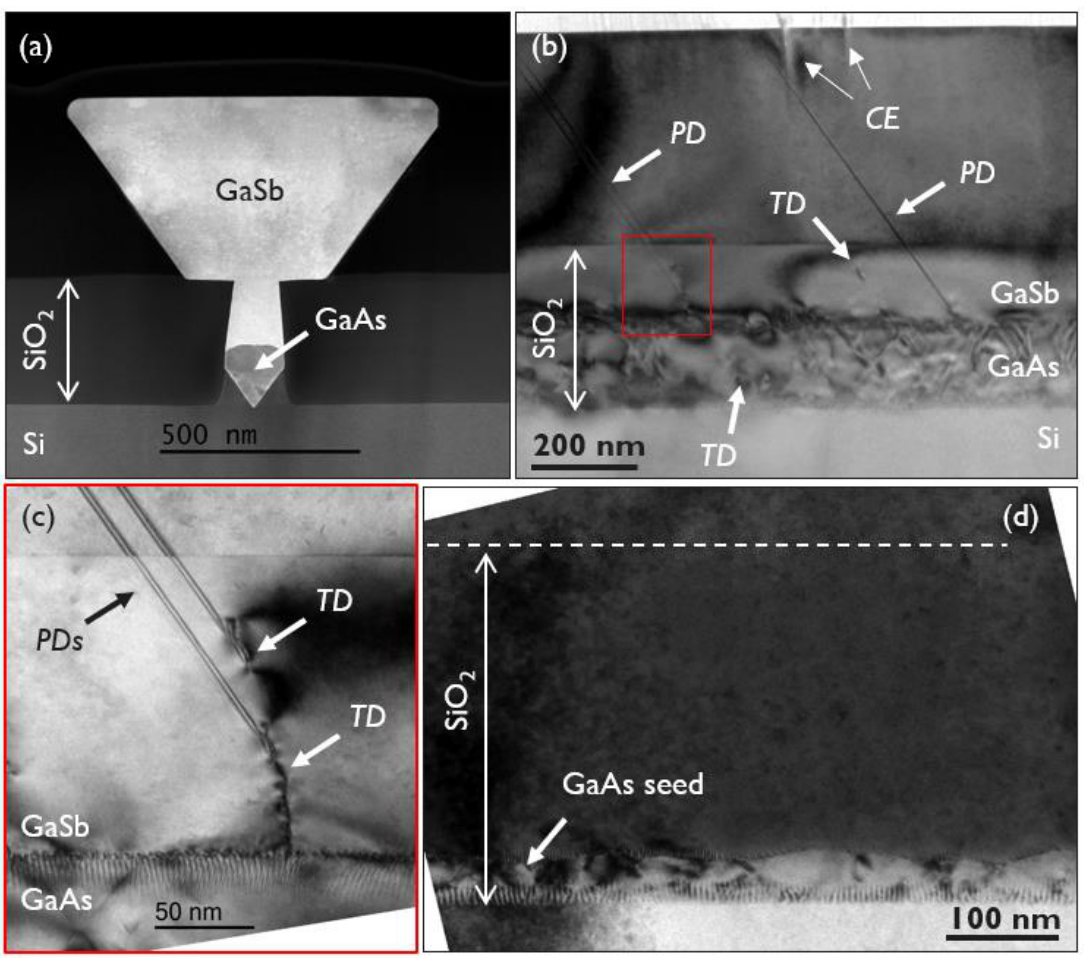
Figure 4. ( a ) to ( c ) are transmission electron microscopy (TEM) images from the GaSb NR sample deposited on a GaAs buffer, whereas ( d ) is a TEM picture from the GaSb NR grown on a GaAs seed layer only. ( a ) is a dark field scanning transmission electron microscopy (DF-STEM) image showing the complete NR across the trench orientation. ( b ) and ( c ) are two-beam (004) BF and (220) BF images obtained in a cut direction along the trench. ( c ) is a larger magnified picture of the region indicated by the red rectangle in ( b ). ( d ) is a two-beam (220) bright field (BF), also prepared in a cut directed along the trench orientation. Contrast artefacts caused by the curtaining effect (CE) are observed in ( b ).